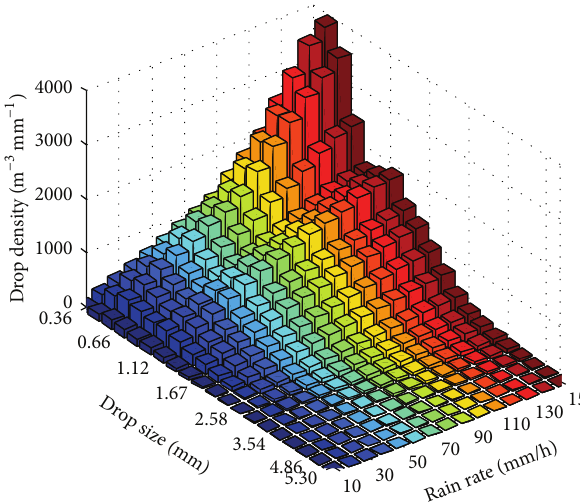
Figure 5: Average drop size distribution as a function of rain rate.